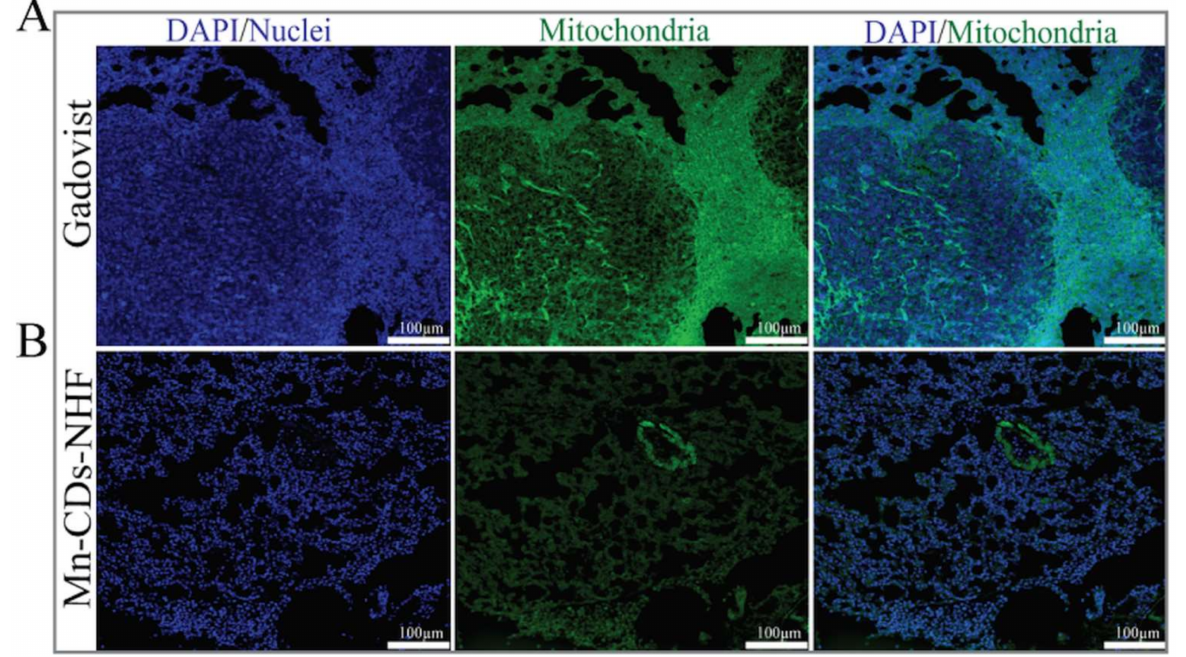
Figure 6. Immunofluorescence staining of mitochondria in paraffin-embedded murine lung specimens. Pictures acquired at 20 × .